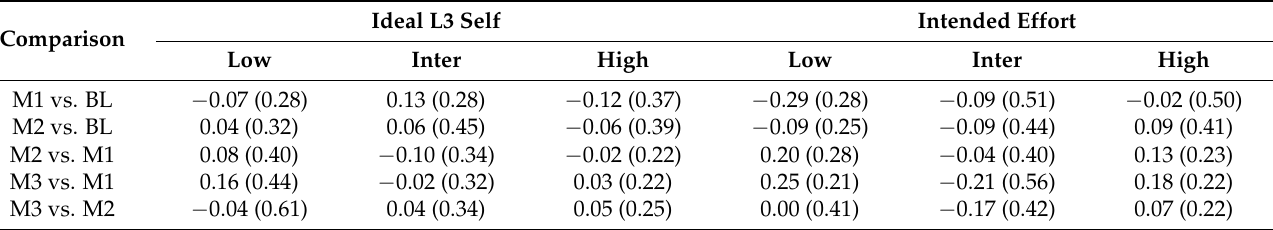
Table 6. Means and SD for gain scores of ideal L3 self and intended effort according to prior Level of ideal L3 self.